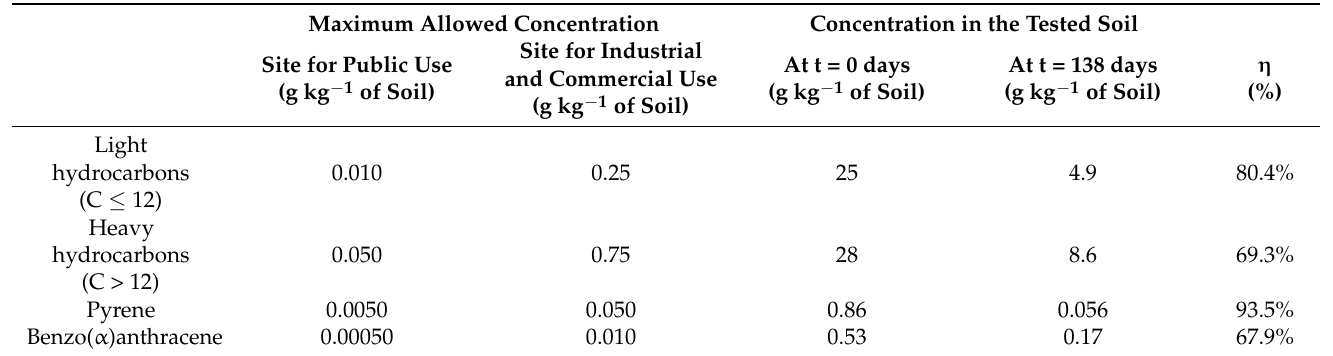
Table 8. Maximum concentration of hydrocarbons according to site use compared with study results. Maximum Allowed Concentration Concentration in the Tested